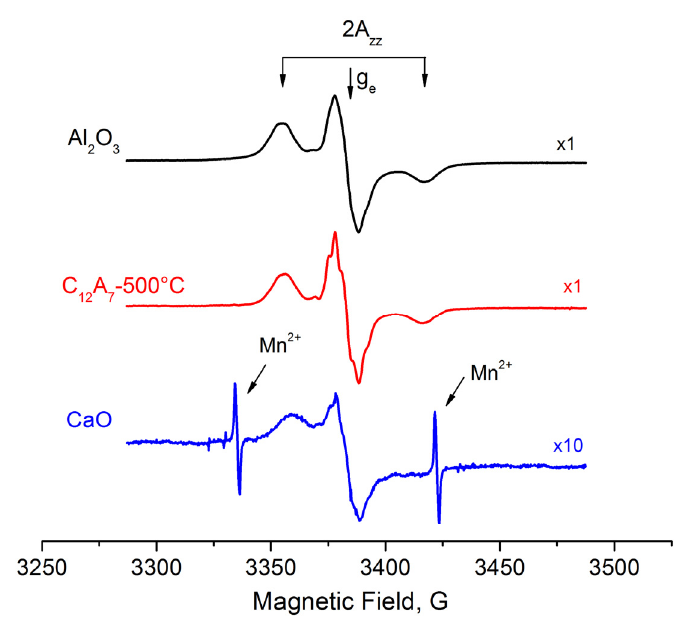
Figure 3. EPR spectra of radical anions on the surface of γ -Al 2 O 3 , C12A7-500, and CaO samples